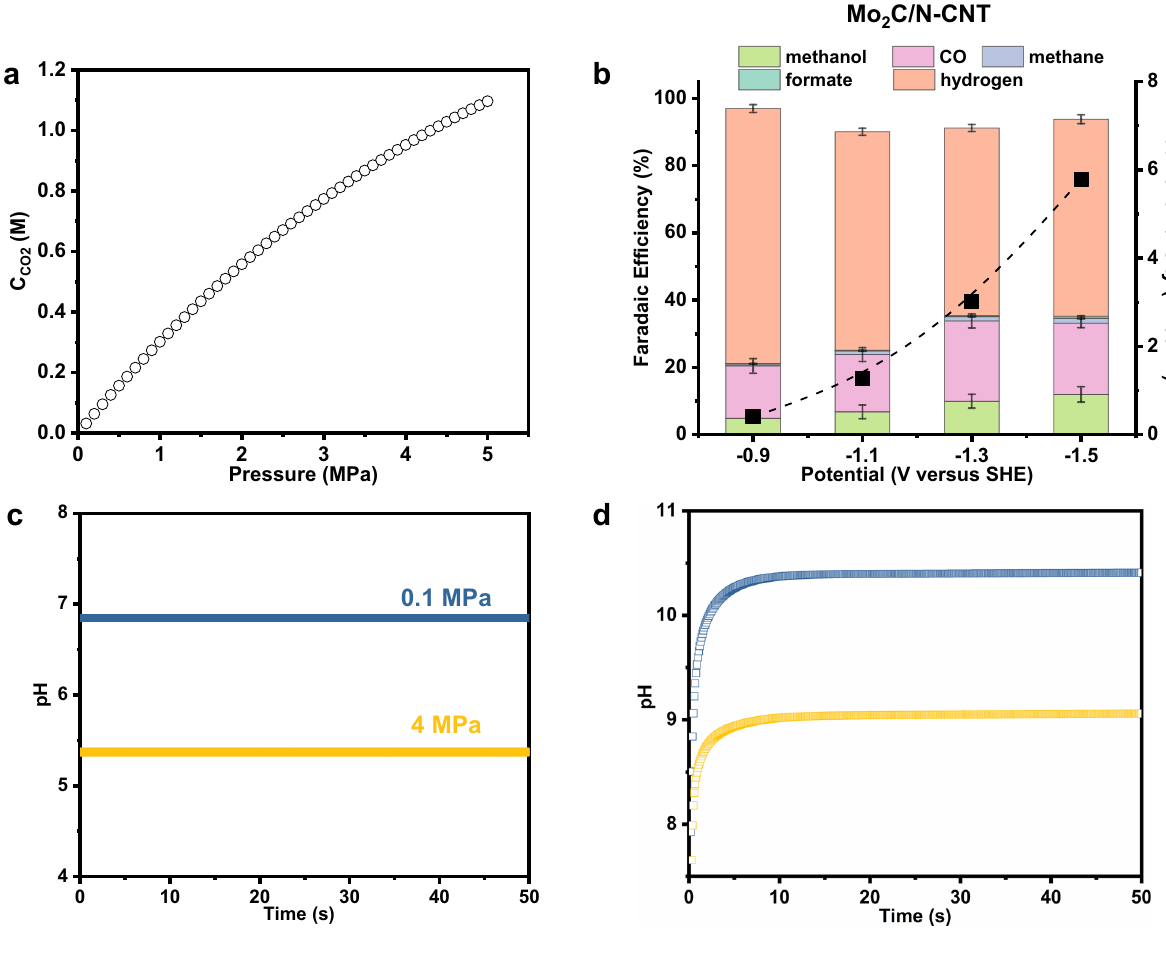
Fig. 3 | Investigation of the effect of CO 2 pressure on catalyst performance. a The CO 2 (aq) concentrations in 0.1M KHCO 3 under different pressures at 25°C. b Productdistributionsof3hCO 2 RRwith0.1MKHCO 3 aselectrolyteunder1atmat various potentials. Two-dimensional plots of the time-dependent pH (under the